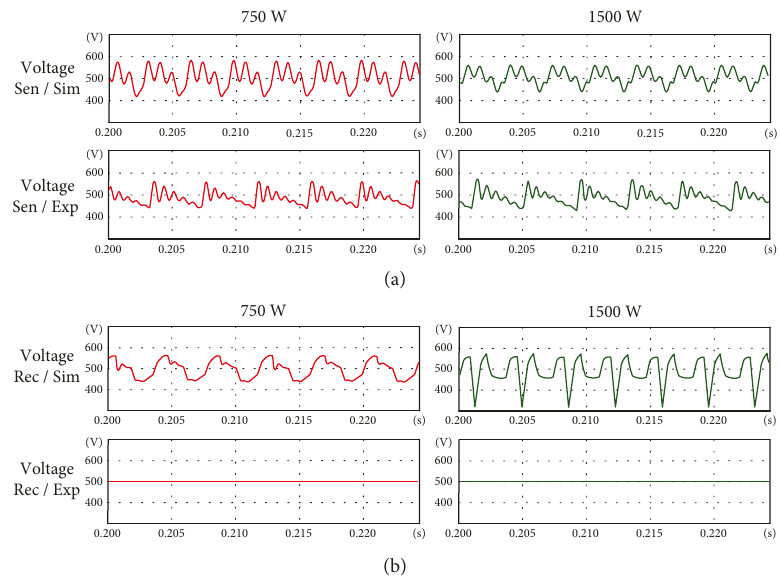
Figure 15: Comparison of the voltage waveforms based on the electrical load conditions. (a) Comparison of the sending side voltage waveforms and (b) comparison of the receiving side voltage waveforms.